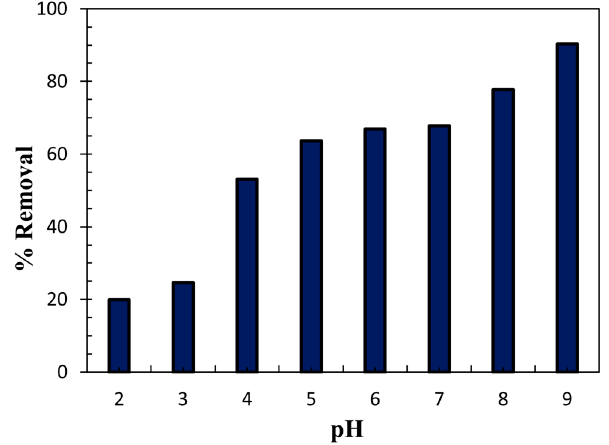
Figure 16. Effect of pH on the adsorption of MB on rGO ( C MB0 = 16 mg/L, W r GO = 8 mg, V = 100 mL, T = 298 K).